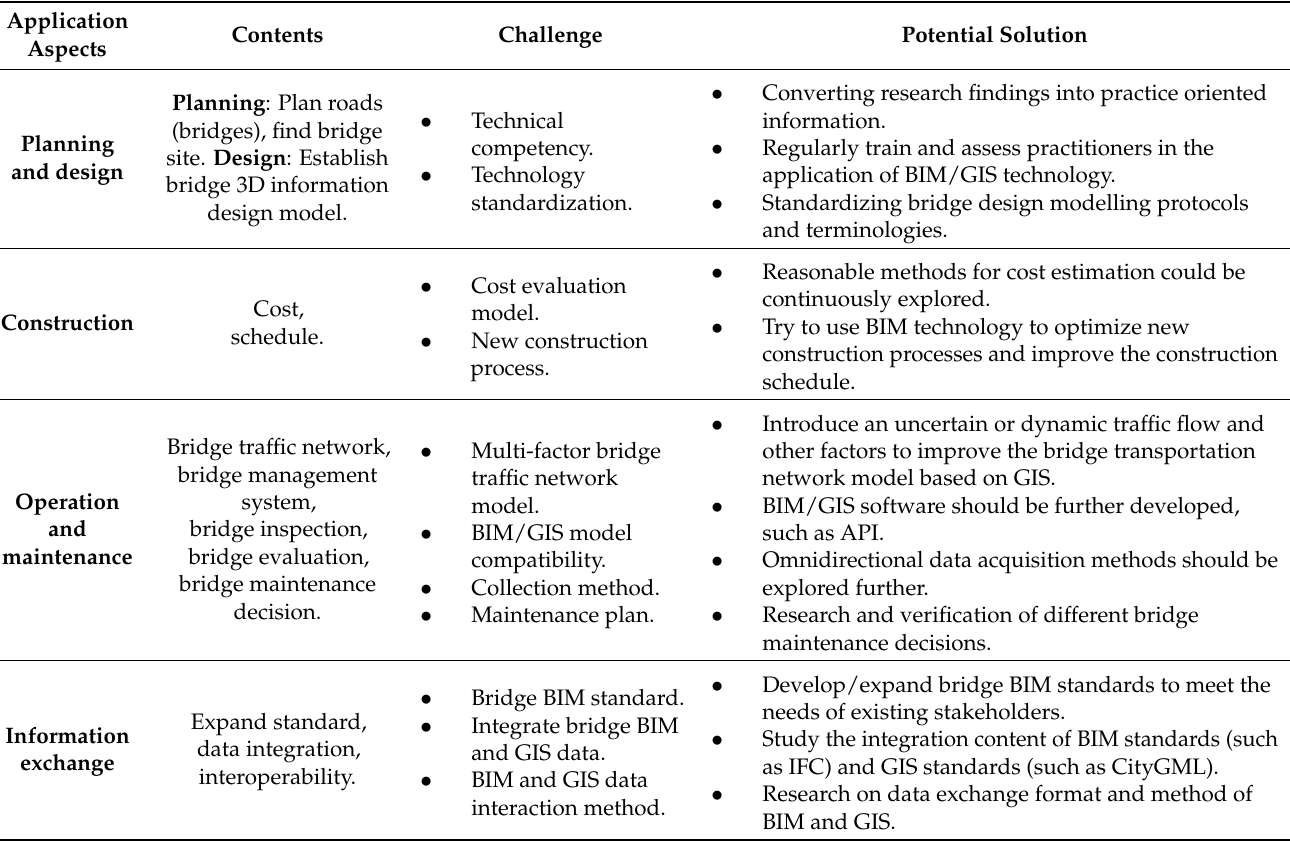
Table 7. Challenges corresponding to the four aspects of analysis and potential